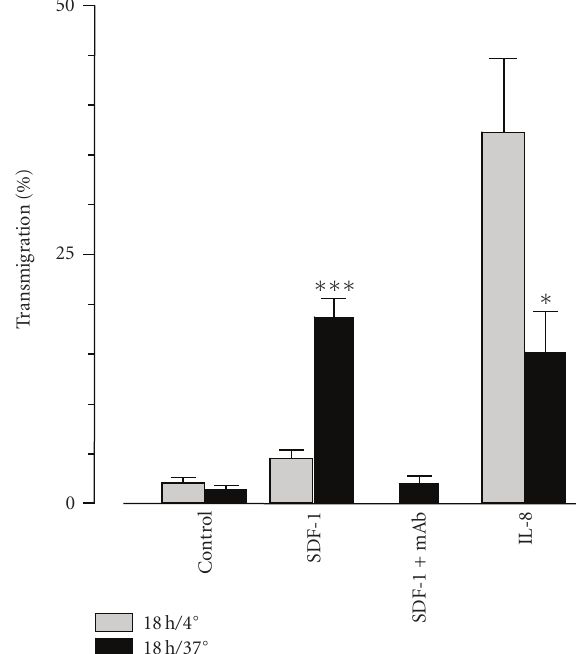
(a) Migration of freshly isolated PMN toward SDF- 1 ( ∗ P ≤ . 05 versus control) and IL-8 ( ∗∗∗ P ≤ . 001 versus control) across microvascular endothelium is shown, n = 6. The specific antibody clone 12G5